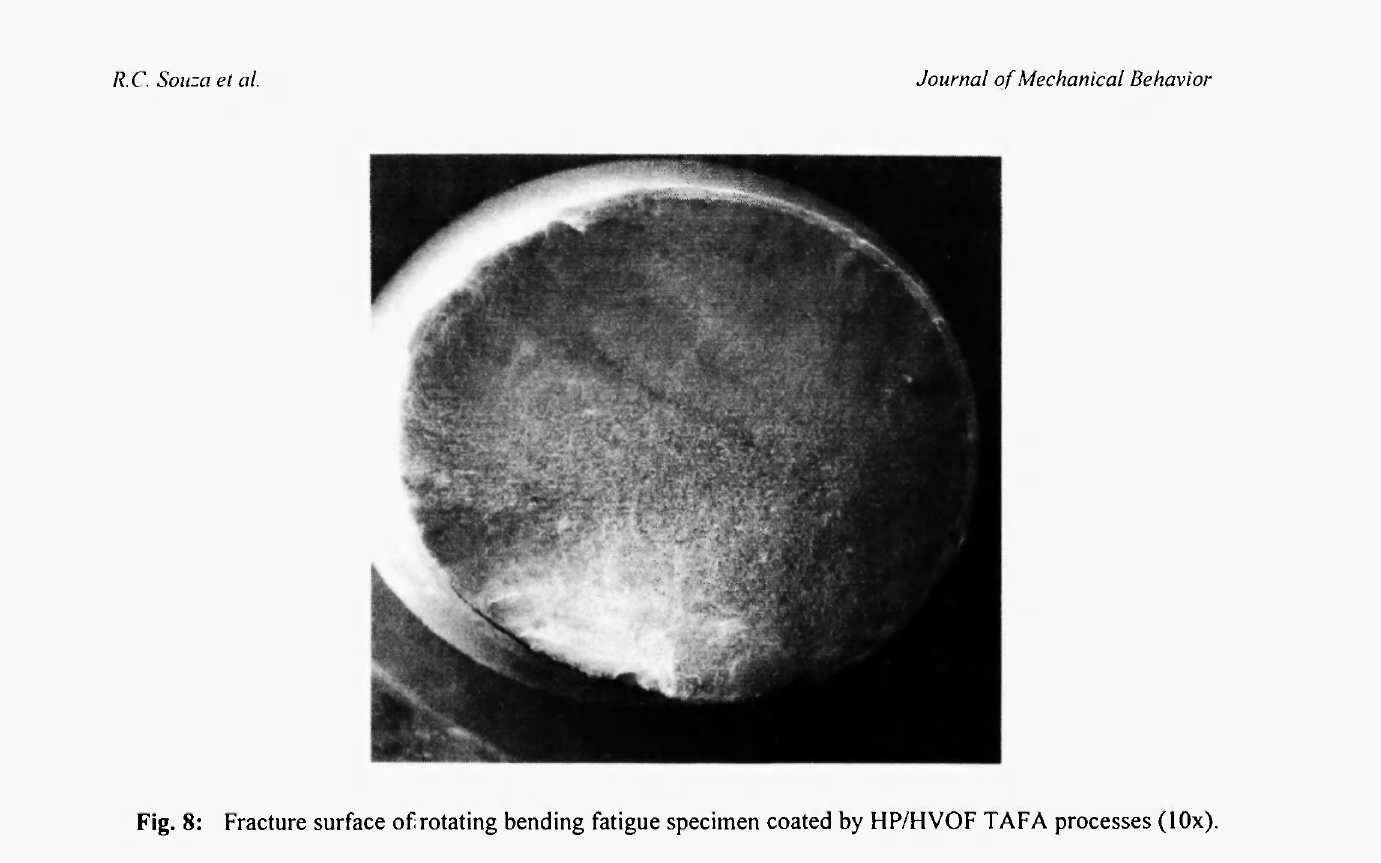
Fig. 8: Fracture surface of rotating bending fatigue specimen coated by HP/HVOF TAFA processes (lOx).